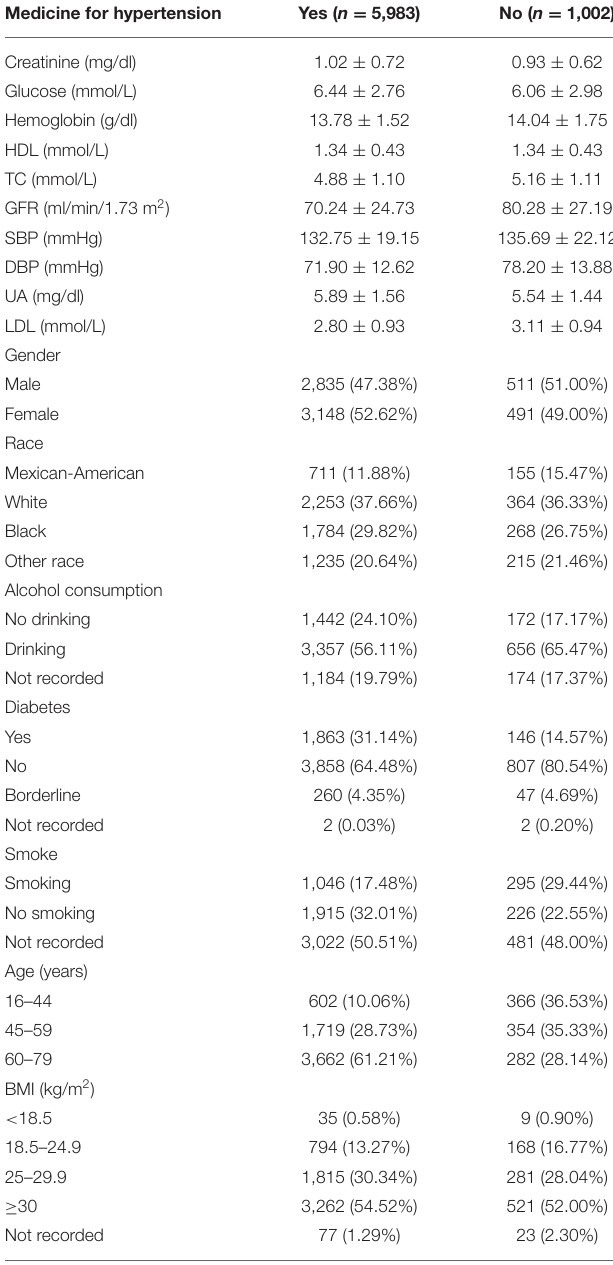
TABLE 1 | Description of 6,985 participants included in this